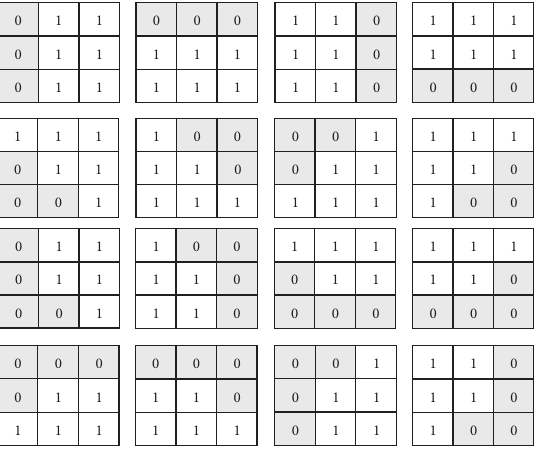
Figure 4: 16 possible binary patterns of images.